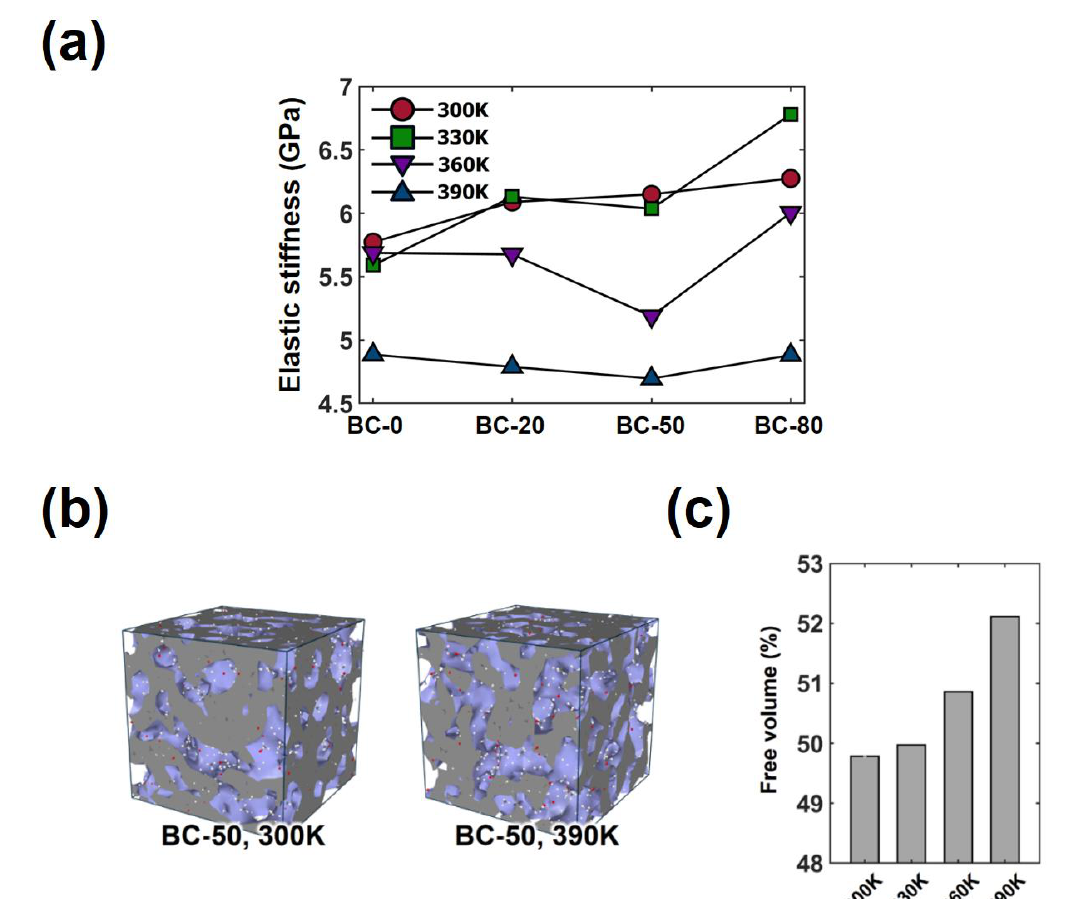
Figure 3. Mechanical tests of PMMA-based BC at different temperatures. ( a ) Elastic stiffness according to the crosslinking ratio. ( b ) Visualization of the BC-50 model with Connolly surface and ( c ) the corresponding free volume fraction derived at each stage of temperature.